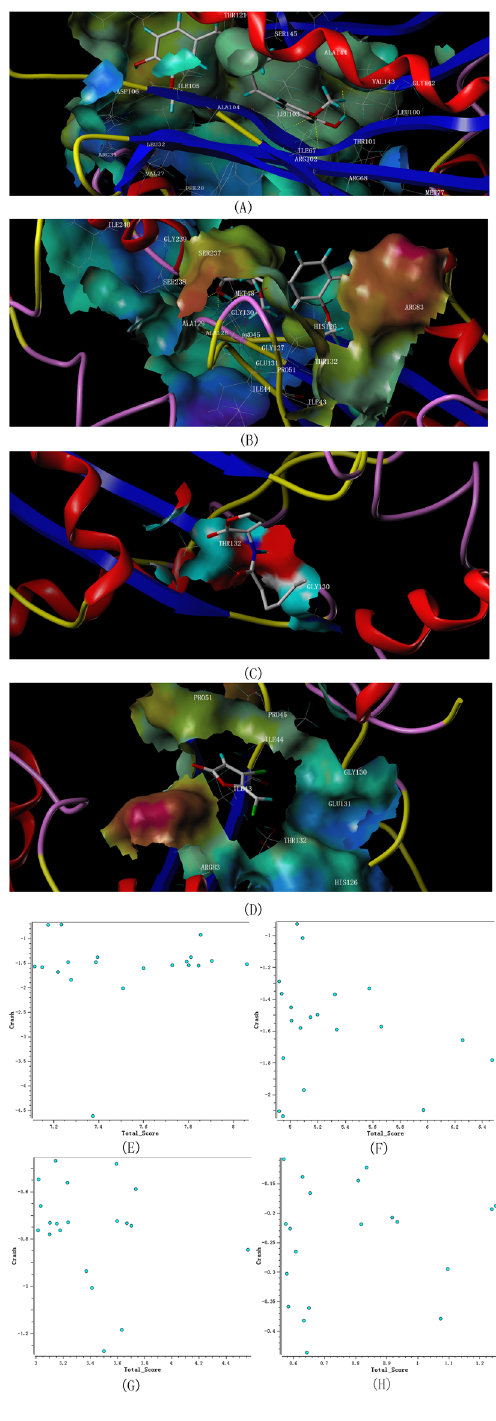
Figure 8. kGraphical representation of LuxI and LuxR type proteins of A. sobria docked with curcumin, C6-HSL and furanone C-30 as well as the conformations of the ligands. Yellow dashed line represents the Hydrogen-bonds. Residues in the active site were labeled. (1) Curcumin docked with modeled LuxI type protein (2) Curcumin docked with modeled LuxR type protein (3) C6-HSL docked with modeled LuxR type protein (4) Furanone C-30 docked with modeled LuxR type protein (5) Conformations of curcumin docked with LuxI type protein (6) Conformations of curcumin docked with LuxR type protein (7) Conformations of C6-HSL docked with LuxR type protein (8) Conformations of furanone C-30 docked with LuxR type